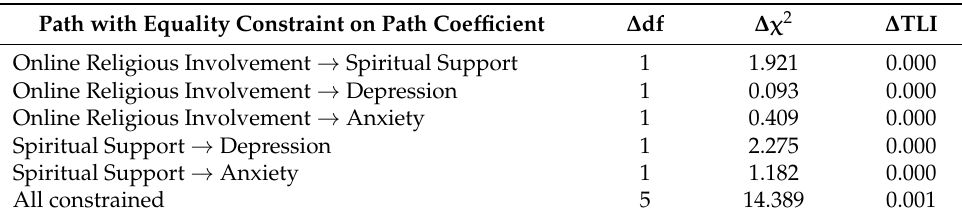
Table 5. Comparison of female and male group differences between the baseline model and models with equality constraints on the path coefficients.